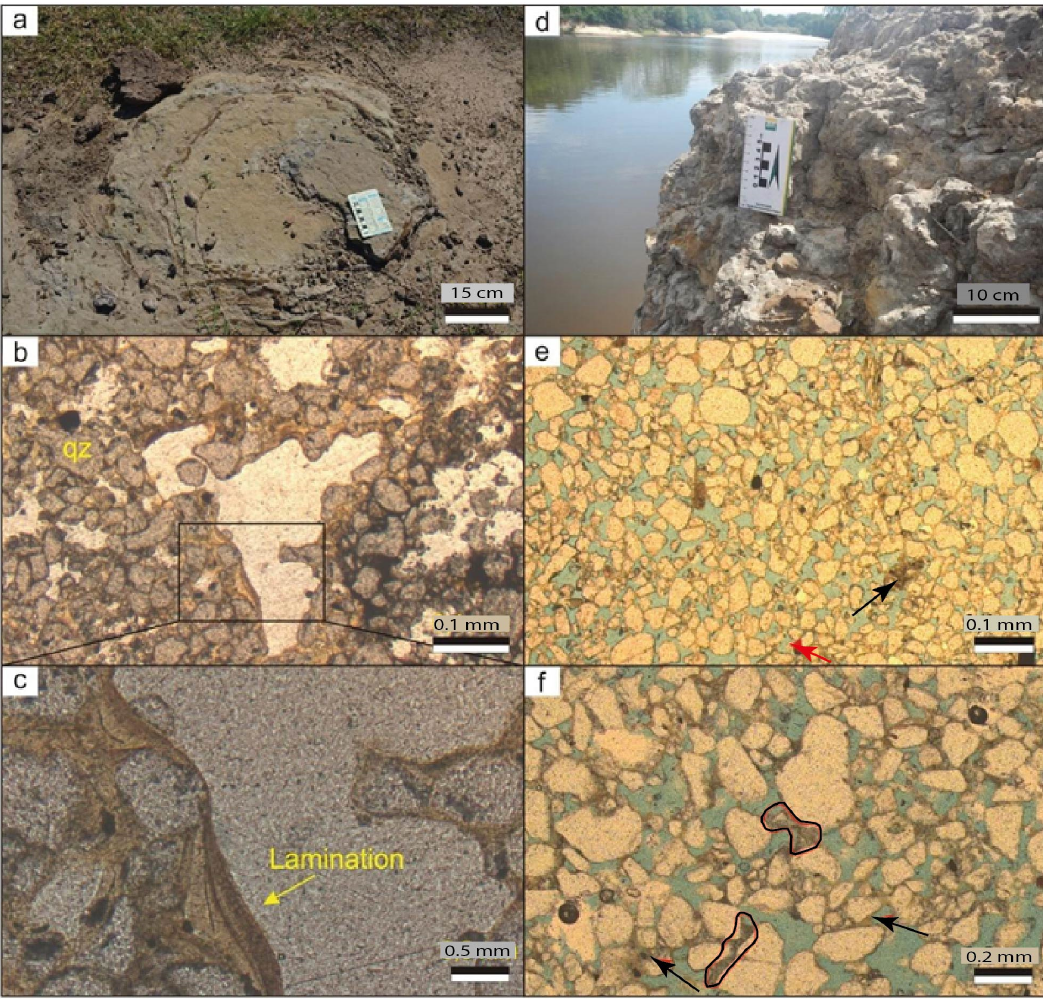
Figure 5. ( a ) Layered crust around Coração lake in 2017; ( b ) photomicrograph of the crust composed by quartz grains, vugy pores and brown clay material coatings; ( c ) detail of the lamination in the clayey material; ( d ) the banks in the margins of the Negro River. The rock is described as a consolidated sandy clay; ( e ) photomicrograph of the sample, with predominance of quartz grains. The black and red arrows indicate, respectively, the brown and the greenish-brown clays; ( f ) detail of the greenish-brown clays between the quartz grains. They usually develop a “bridge” aspect (red polygons) between adjacent grains.